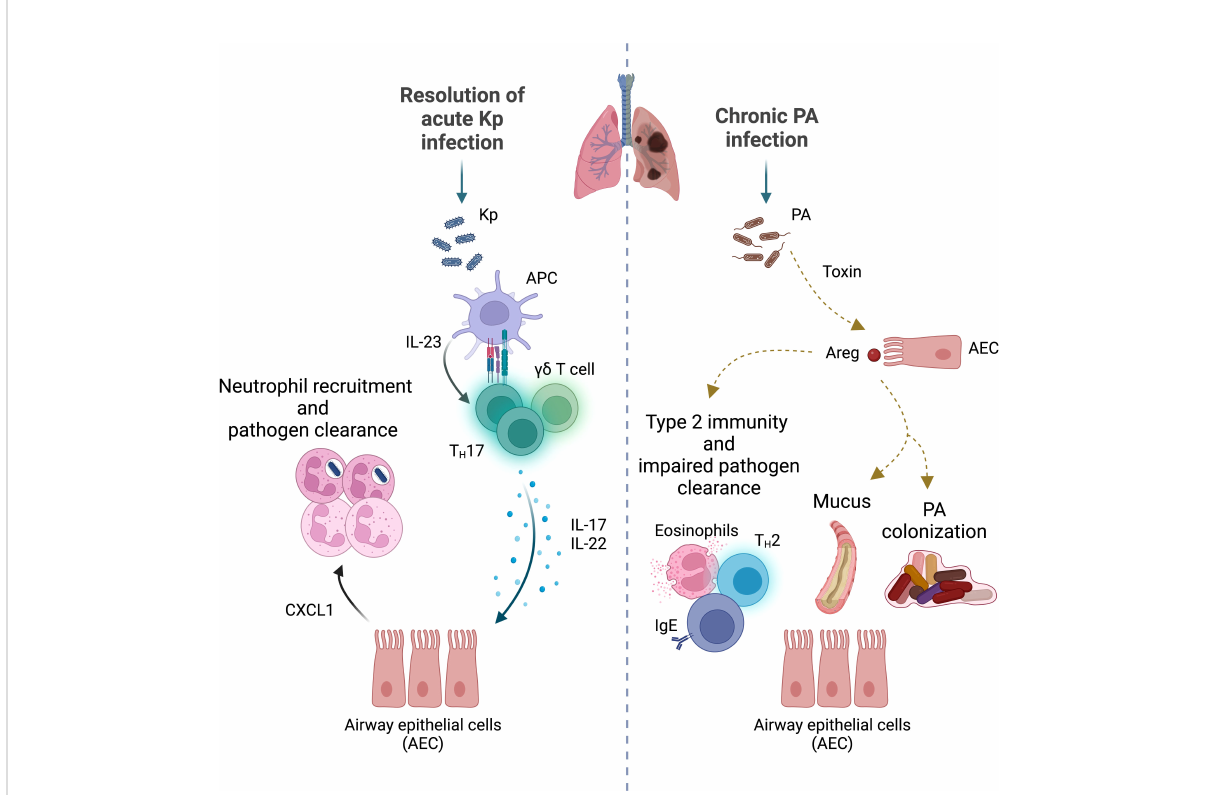
FIGURE 1 Protective versus pathogenic T cell immunity to Gram-negative bacteria. Left panel: Upon infection with Klebsiella pneumoniae (Kp), antigen presenting cells (APC) recognize and present pathogenic peptides to T cell subsets in local lymph nodes. APC release polarizing cytokines (e.g., IL-23) that activate T H 17 and gd T cells. These T cell subsets produce IL-17 and stimulate airway epithelial cells (AEC) to express chemokines (e.g., CXCL1) that mediate neutrophil recruitment to the infection site. Activated neutrophils phagocytose and kill bacteria, therefore enhancing Kp clearance and resolution of local in fl ammation. IL-22 serves a protective role by promoting AEC repair. Right panel: Pseudomonas aeruginosa (PA)-derived toxin activates the amphiregulin (Areg) – Epidermal Growth Factor (EGF) receptor pathway to induce a type 2 in fl ammatory response and increase mucus production, enhancing pathogen survival. Deviation of the immune response toward pathogenic expansion of T H 2 immunity, creates a favorable niche for PA colonization and chronic infection. Chronic PA exposure can result in increased T H 17 cell activation, persistent neutrophil recruitment, and lung tissue damage ( not shown